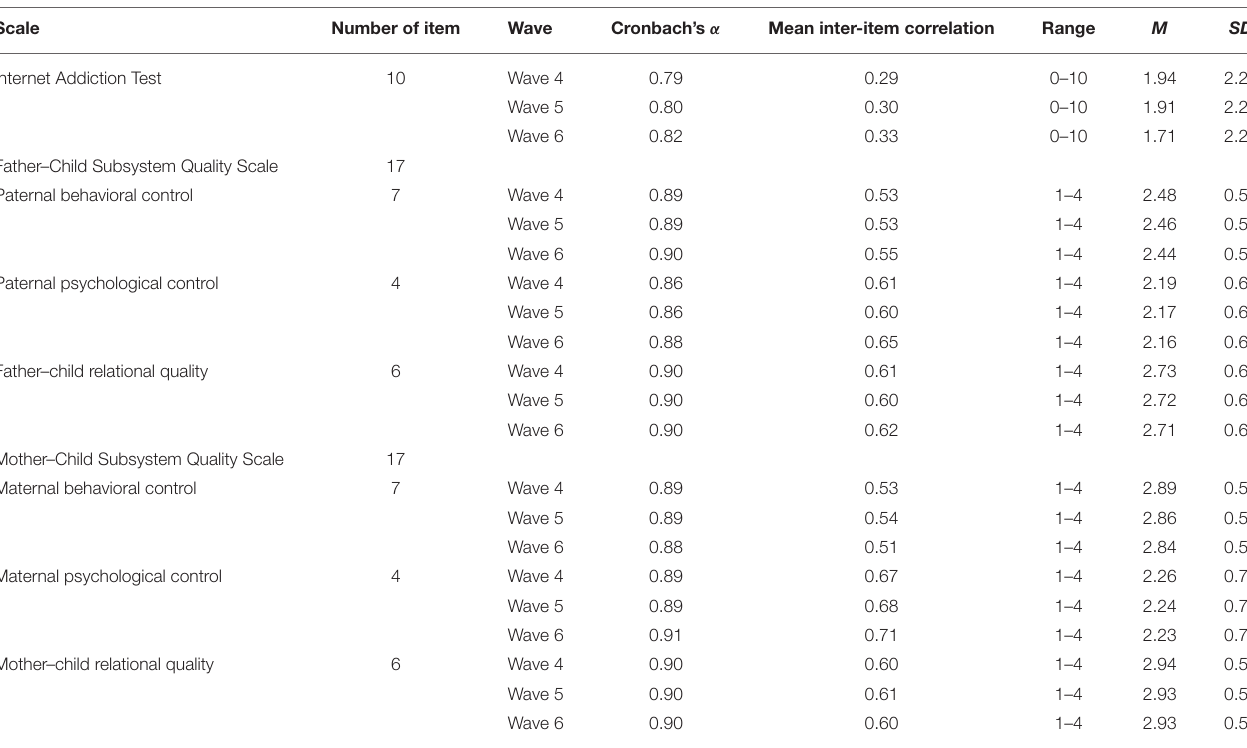
TABLE 3 | Reliability of scales and description of variables across the three